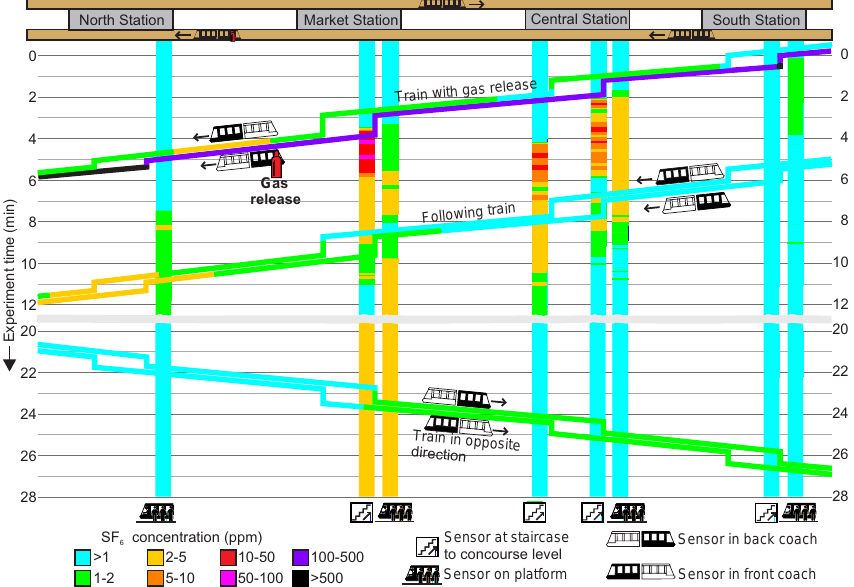
Figure 6. Tracer gas release inside a running train in the back coach. The lines represent the measured concentration while the train is running. The bars represent sensors on the platforms inside the station.